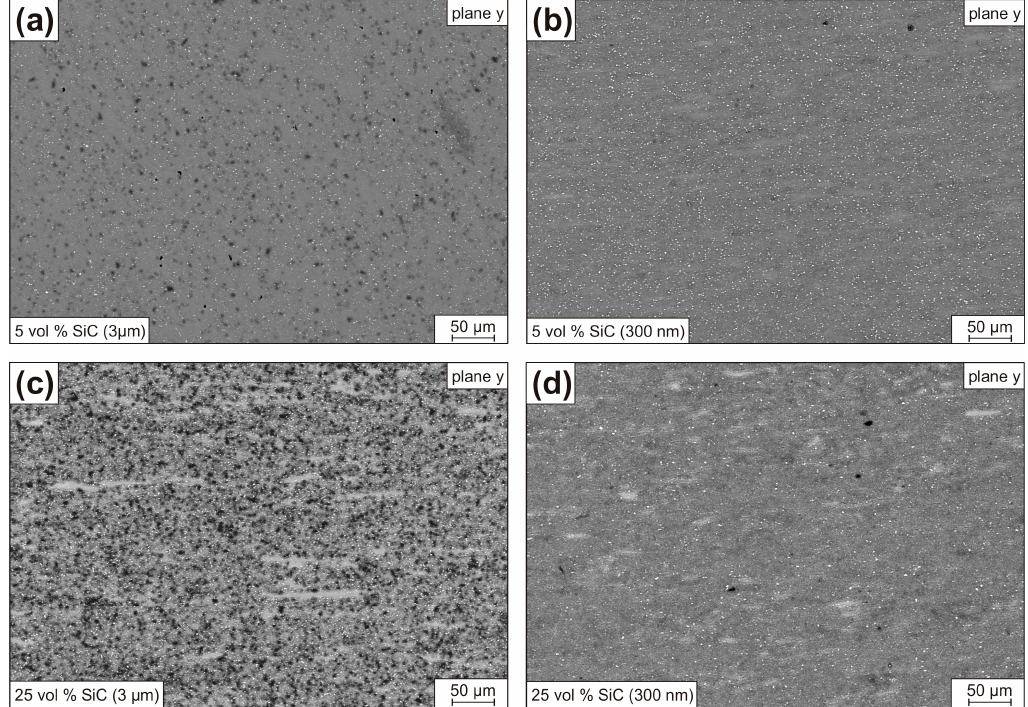
Figure 2. Quadrant back scatter diffraction (QBSD) micrographs of the 2124 aluminum alloy reinforced with ( a , b ) 5 vol % and ( c , d ) 25 vol % SiC particles with a size of ( a , c ) 3 μ m and ( b , d ) 300 nm. The reinforced conditions exhibit areas without reinforcement component (matrix is light grey, particles are dark grey, Al 2 Cu precipitates are white).